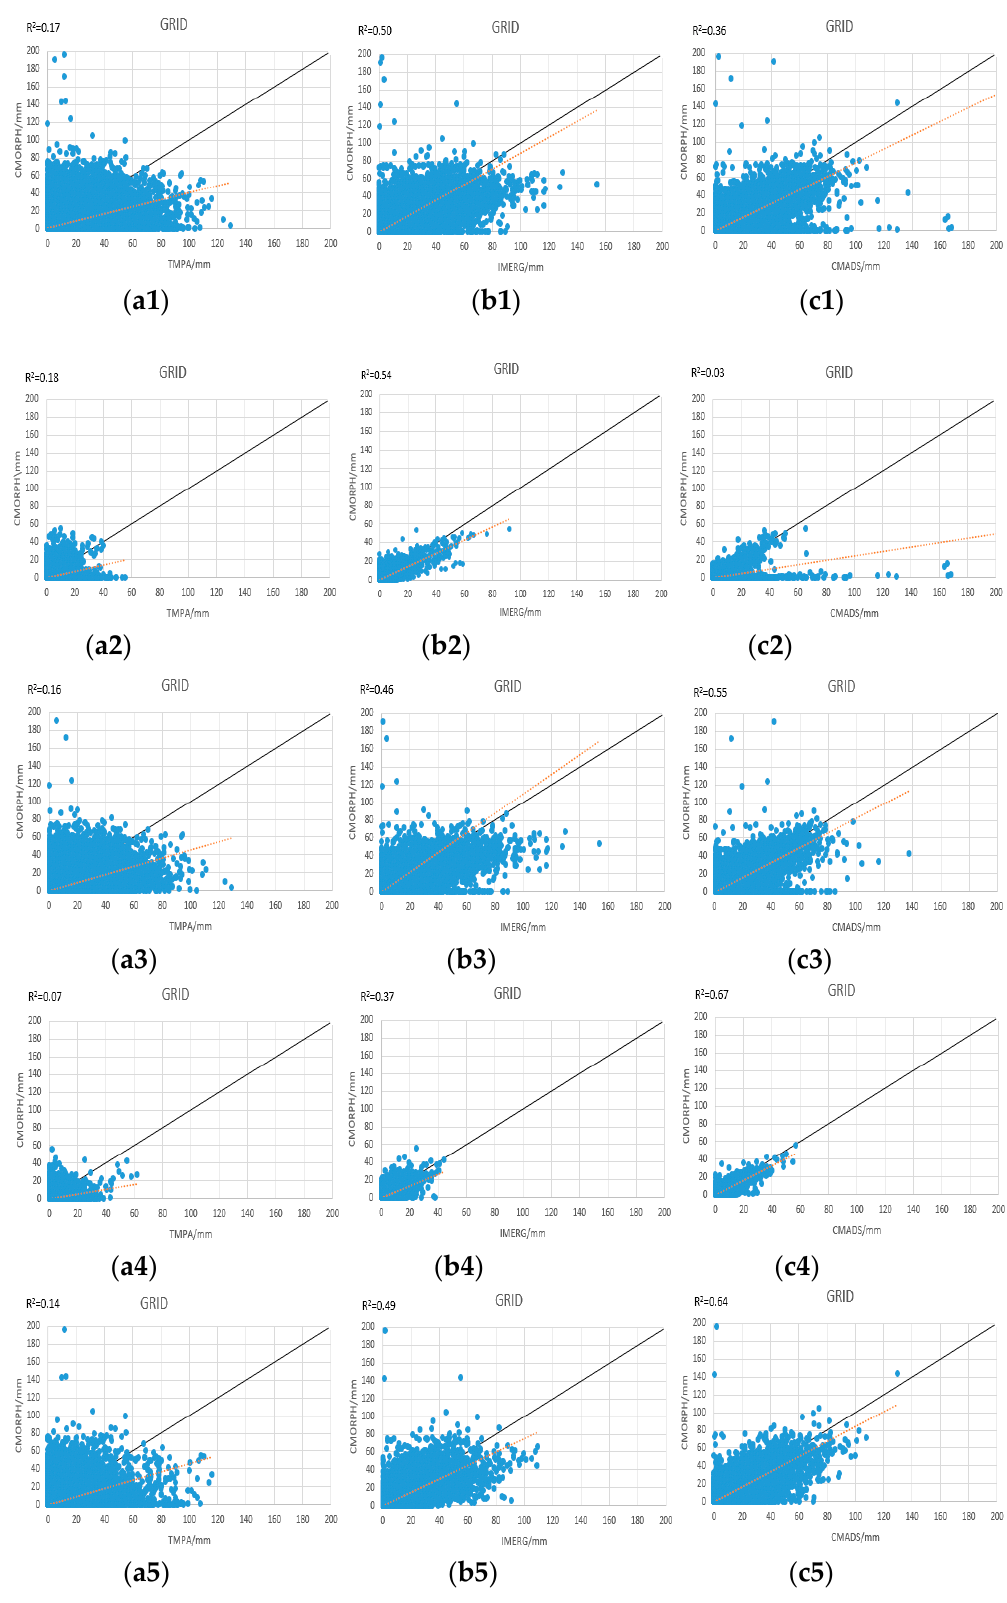
Figure 3. Unary linear scatterplot ( a1 – a5 ), ( b1 – b5 ) and ( c1 – c5 ) represent the full 2014–2016 cycle, first dry season, first rainy season, second dry season and second rainy season for the TMPA, IMERG and CMADS precipitation products.